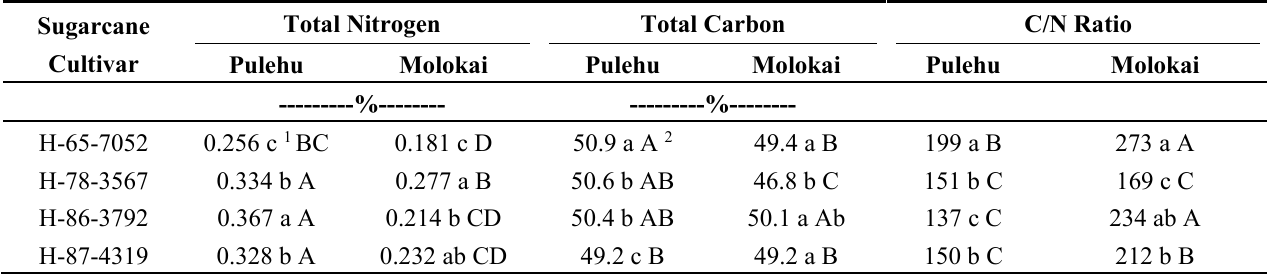
Table 3. Total Nitrogen and Carbon and C/N Ratio of Sugarcane Cultivars Plant Samples Collected Less Than Two Weeks Prior to Harvest